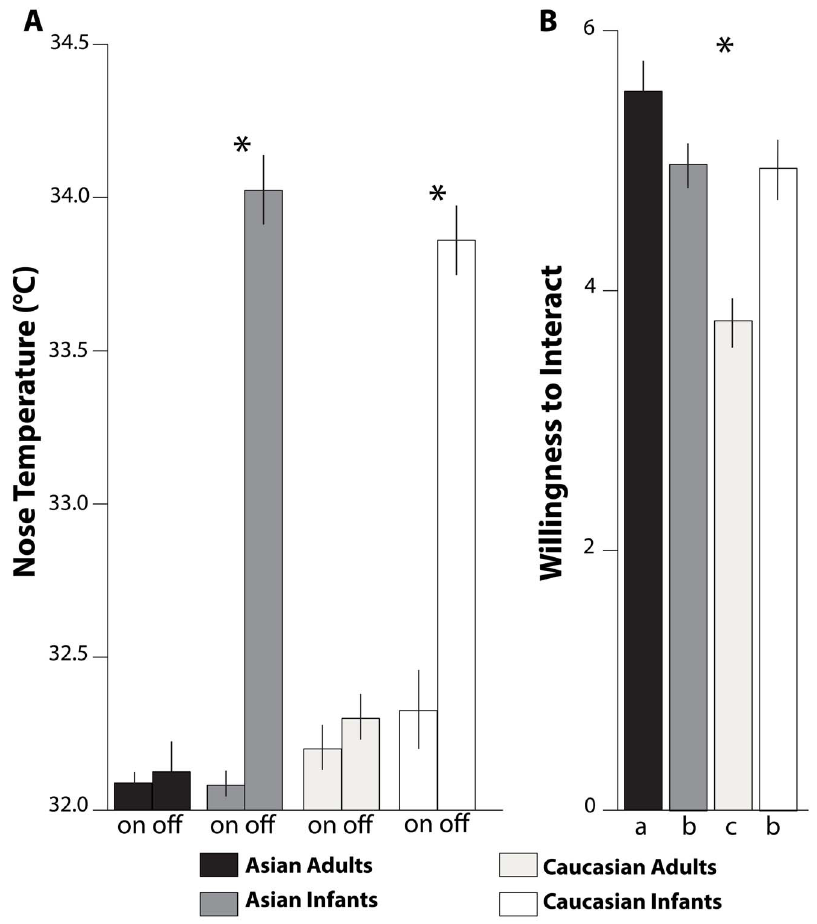
Figure 2. Japanese participants. Responses to the presentation of the faces of Asian adults (black), Asian infants (dark grey), Caucasian adults (light grey), and Caucasian infants (white). (A) Mean levels ( 6 SEM) of the tip of the nose temperature at onset (on) and offset (off) of picture presentation. (B) Mean levels ( 6 SEM) of scores for Willingness to Interact with the person. Bars with different subscripts (a, b, and c) are significantly different in Tukey HSD post-hoc tests.